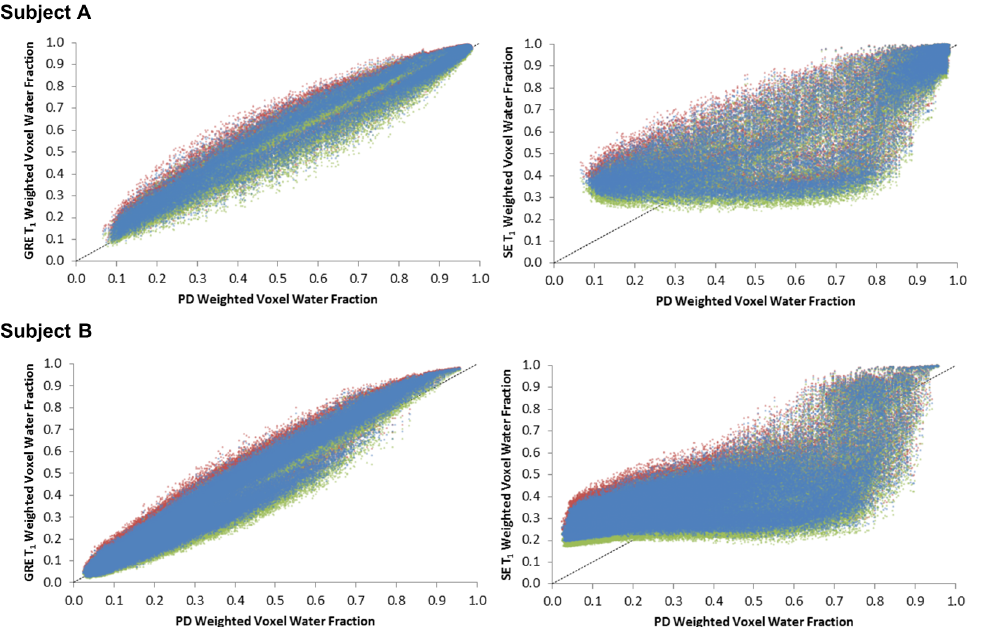
Fig 6. Low resolution voxel water fractions for corrected GRE and SE T 1 -weighted data ( left and right , respectively ) vs . corrected GRE PD- weighted data showing the minimal perturbation in water fraction values caused when the original signal correction ( blue ) is altered by +15% and -15% ( red and green , respectively ) for the right breast of two subjects. The relationship between SE T 1 -weighted data and GRE PD-weighted data is not linear; A) 26 year old volunteer with 64.6% FGT and B) 50 year old volunteer with 18.4%